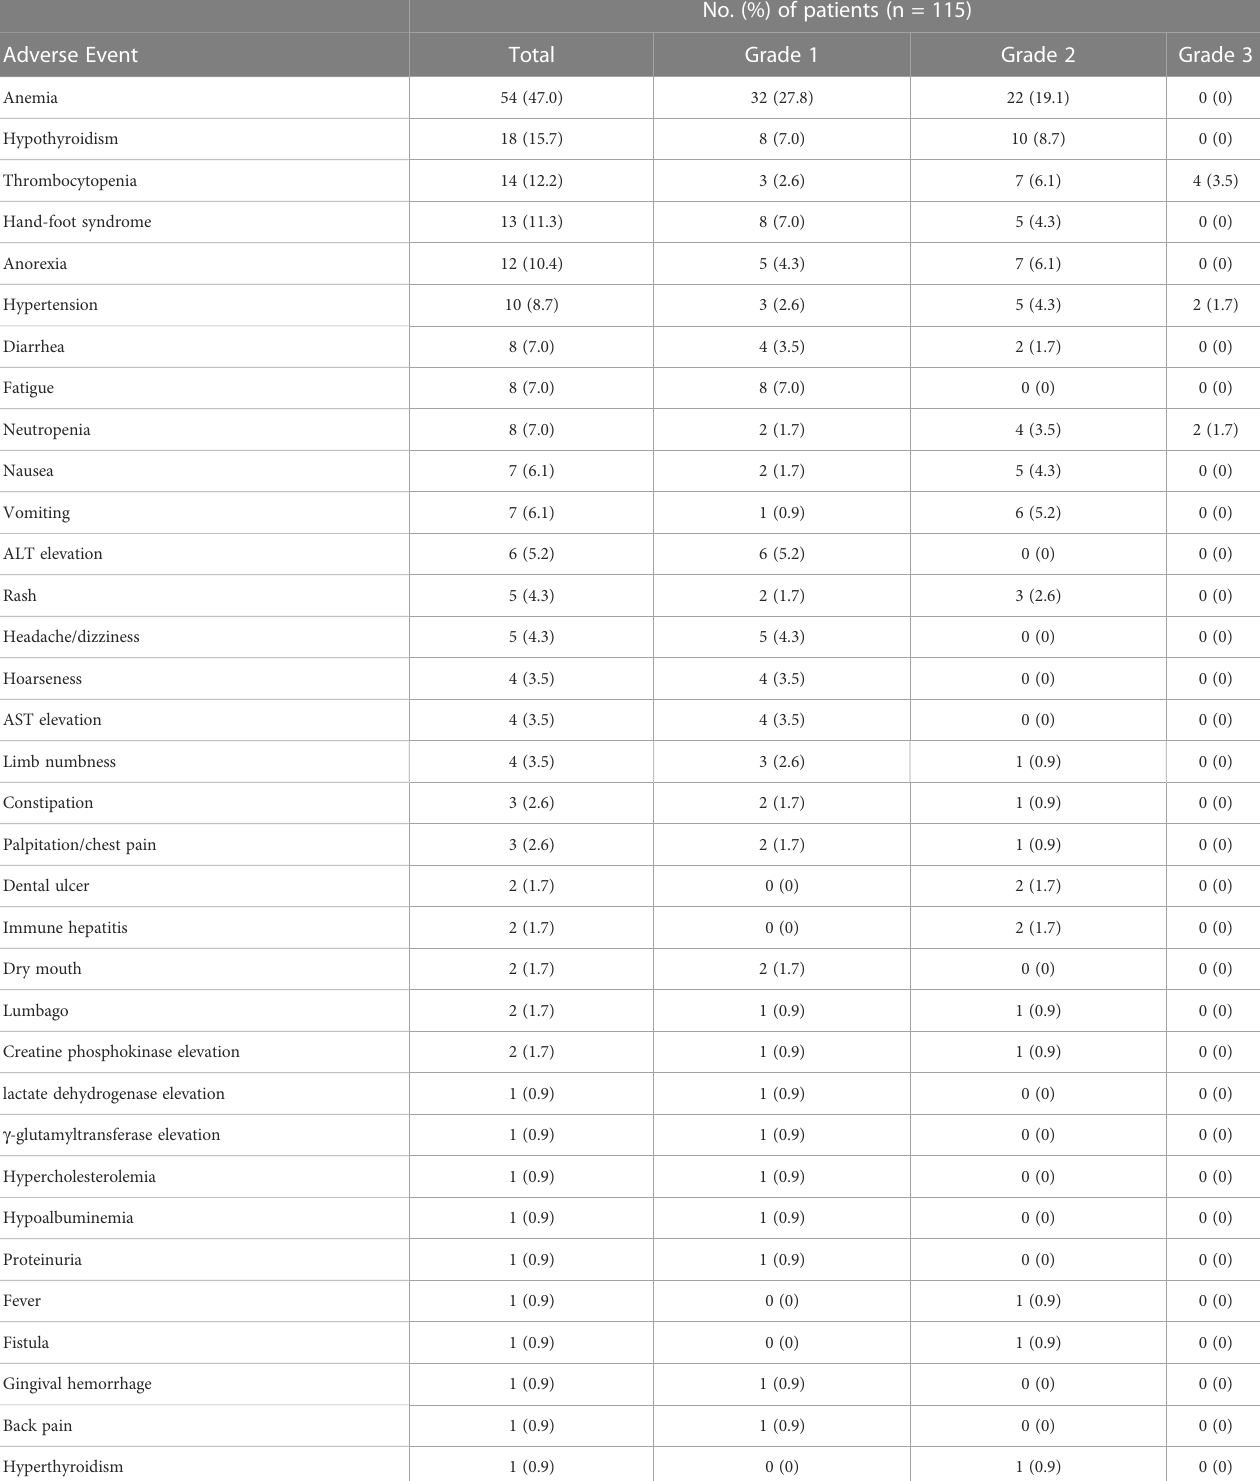
TABLE 3 Treatment-related adverse events in all treated